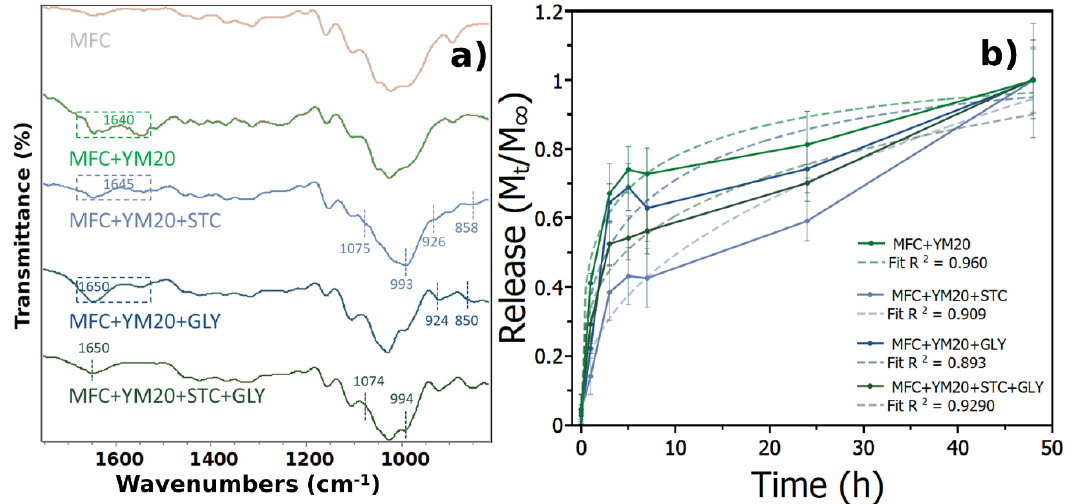
Figure 3. ( a ) Casting films FTIR spectra, assigned numbers signify the formation of new bands by the addition of the specific material. ( b ) Yerba mate extract release with best-fit using Korsmeyer − Peppas correlation for each curve.